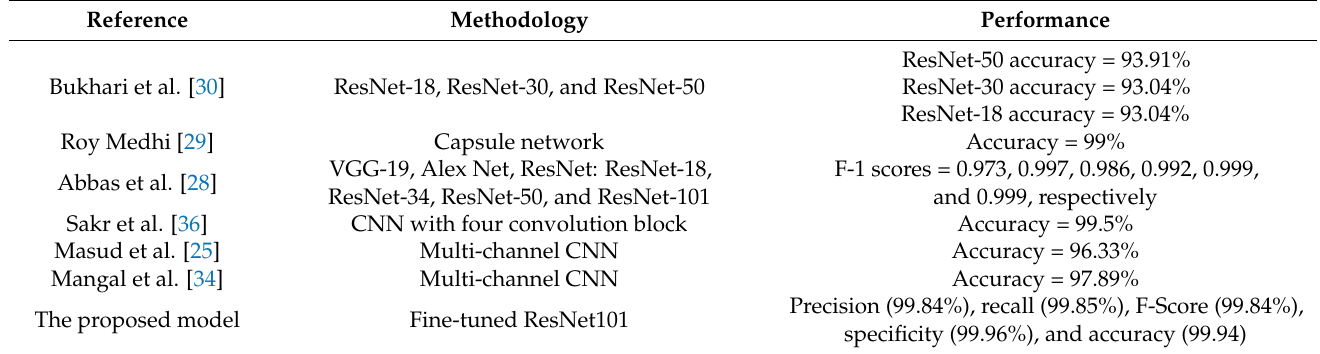
Table 5. The comparison of the proposed model and the state-of-the-art